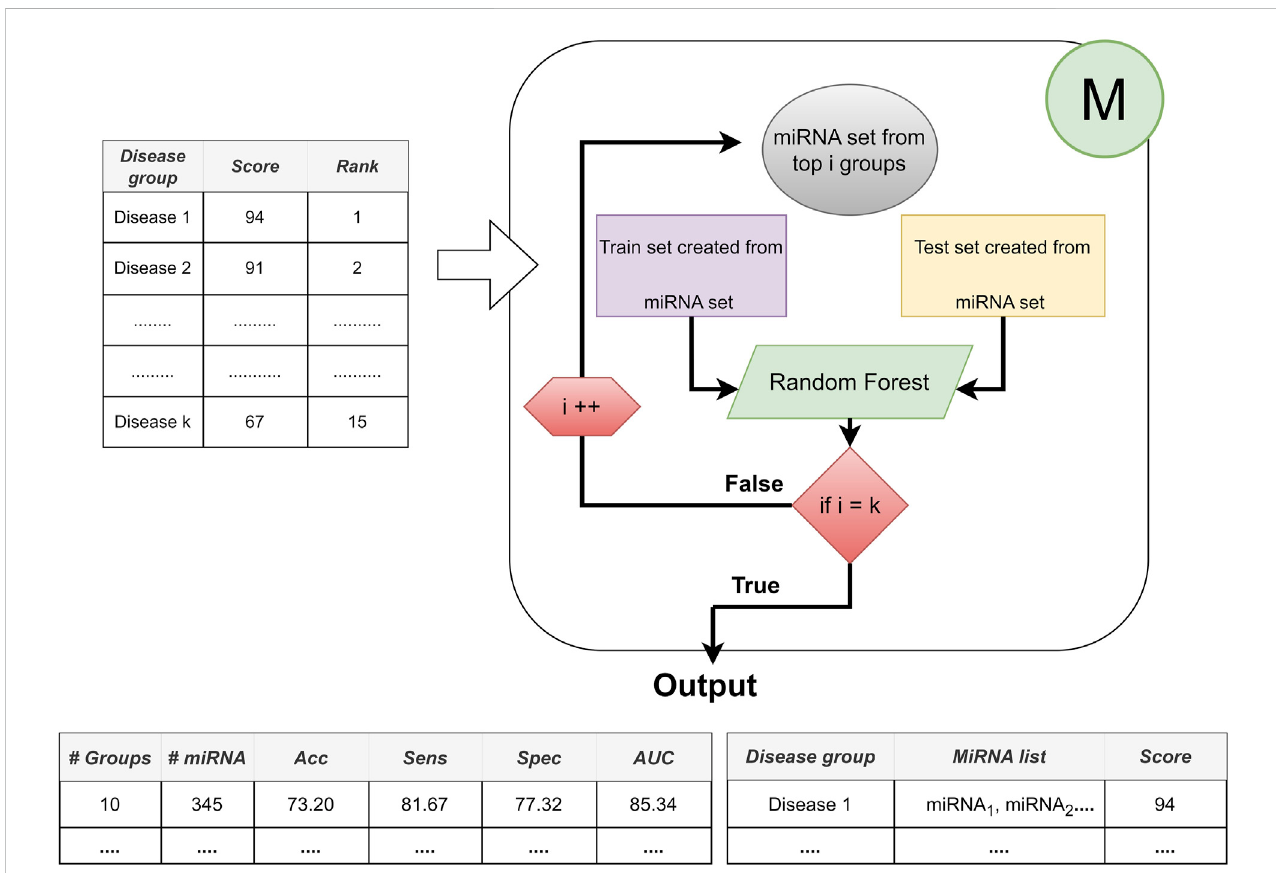
FIGURE 5 The architecture of Component M: Providing the best performance with the best feature set based on disease combinations.